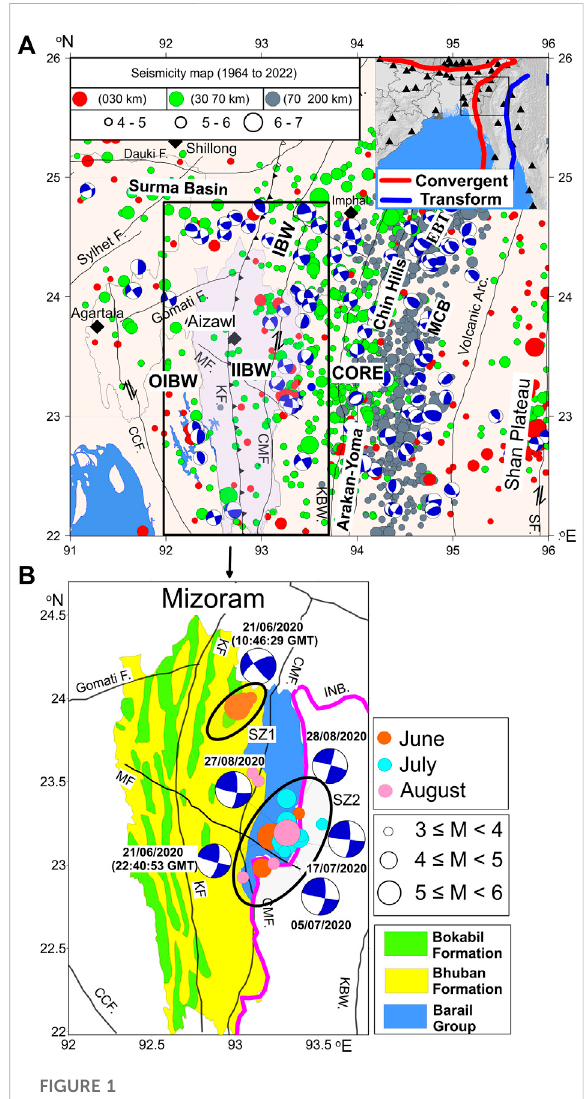
FIGURE 1 (A) Tectonic map of Mizoram and its surrounding areas; seismicitydatafortheperiod1964 – 2022arecollectedfromwww. isc.ac.uk and overlapped over the tectonic map. The seismicity data is plotted based on increasing magnitude and depth, the labels used for representing magnitude and depth are given in the legend section, which is placed in the upper left corner of the Figure 1A. Fault plane solutions of some selected events are also overlapped over the map (source: www.globalcmt.org). Abbreviations used are T, Thrust; F, fault, CCF, Chittagong Coastal Fault; CMF, Churachandpur-Mao Fault; KF, Kaladan Fault; EBT, Eastern Boundary Thrust; SF, Sagaing fault, KBW, Kabaw Fault and MF, Mat Fault. Important cities are presented with black diamonds and Mizoram state is highlighted with light blue colour and shown inside the black box. (B) The geology of Mizoram state is provided in Figure 1B. Events that occurred from June to August 2020 are plottedoverthemapandlabelled.Faultplanesolutionsofsomeof the events are also shown by beach ball representation (source: www.globalcmt.org). Important tectonic elements cutting across the State are also shown and labelled. The big and small ellipse represents clusters SZ1 and SZ2